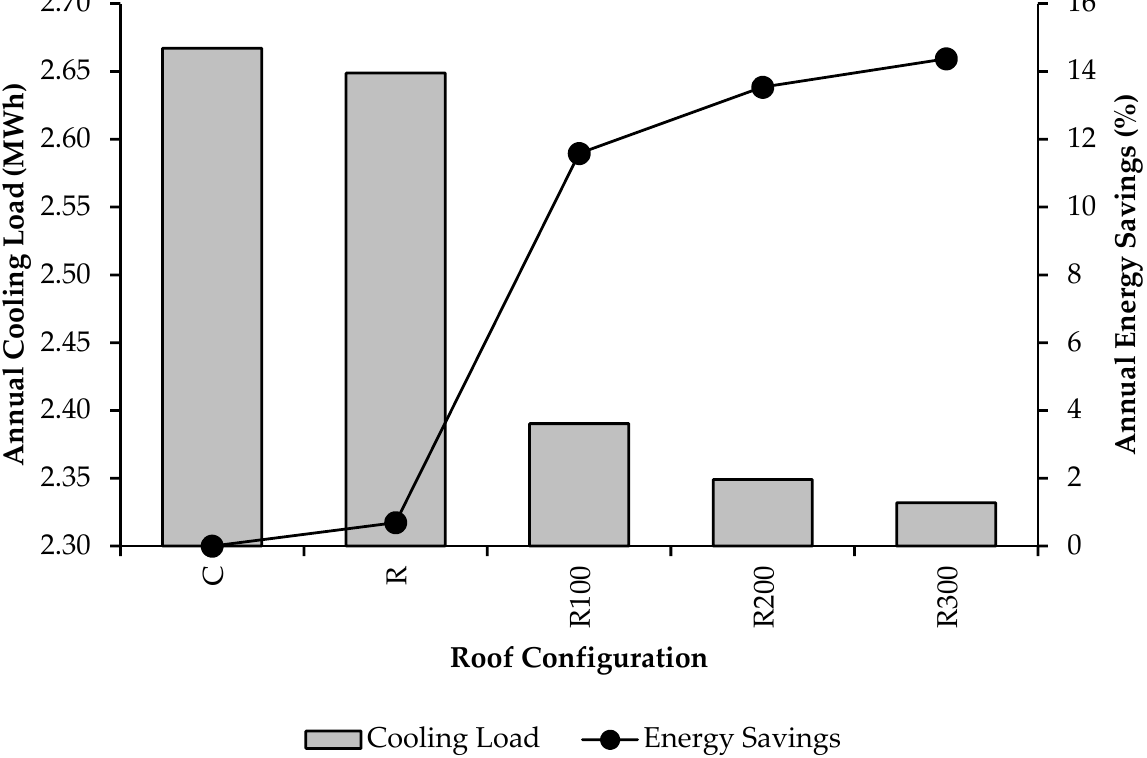
Figure 14. Annual cooling load and energy savings of the BIM at varying roof configurations.